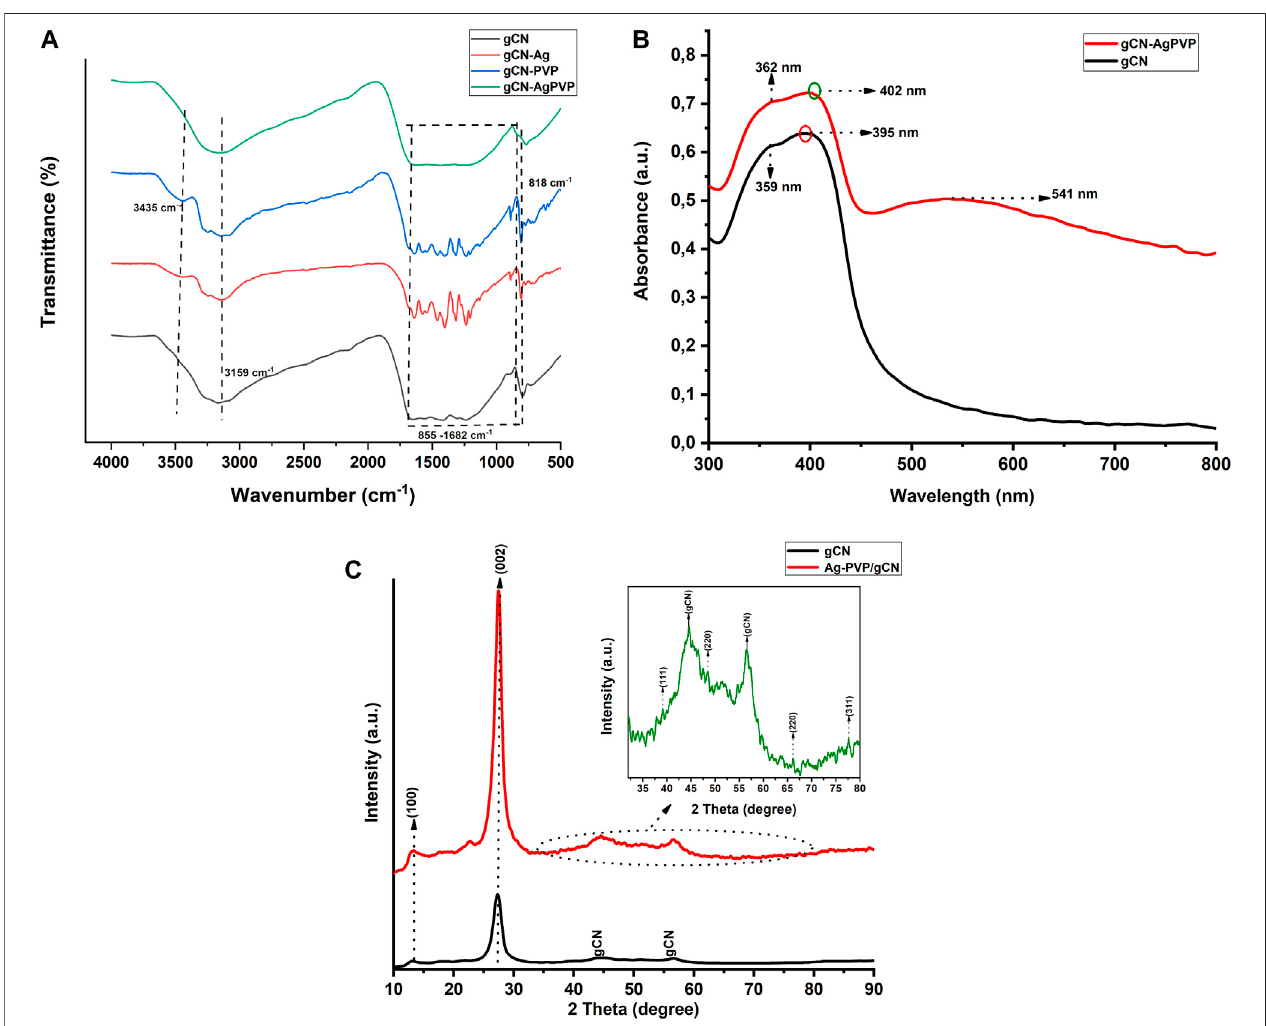
FIGURE 1 | (A) FTIR spectra of the gCN, gCN-Ag, gCN-PVP and gCN-AgPVP composite. (B) UV-vis diffusion re fl ectance spectra of prepared gCN and gCN-Ag PVP composite. (C) XRD patterns of the prepared, a) GCN and b) GCN-AgPVP composite.